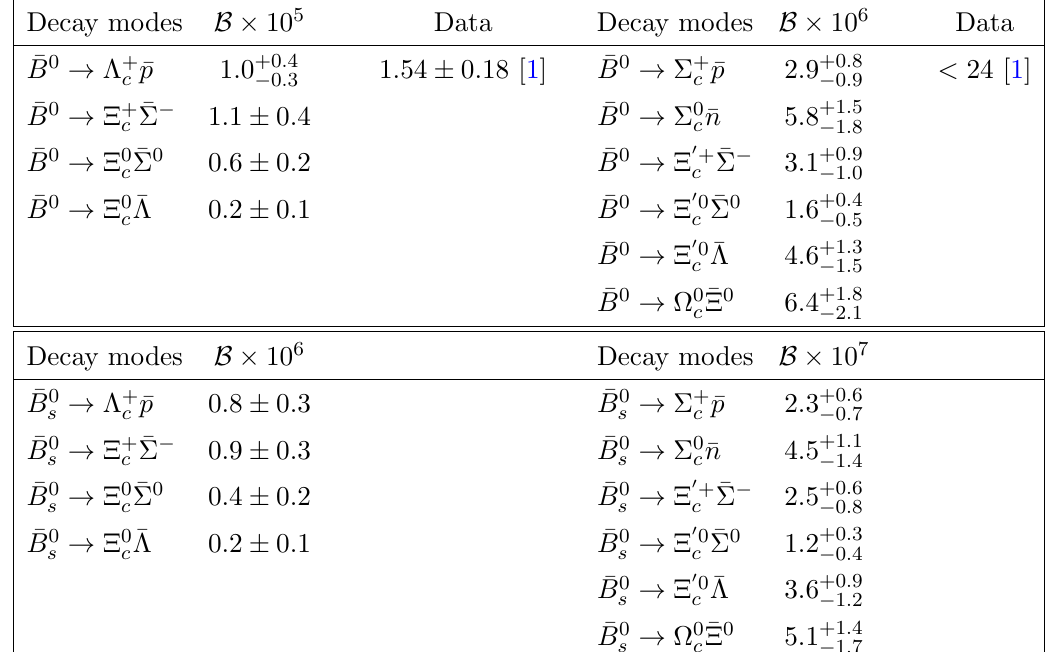
Table 3 . Branching ratios of the (cid:22) B 0